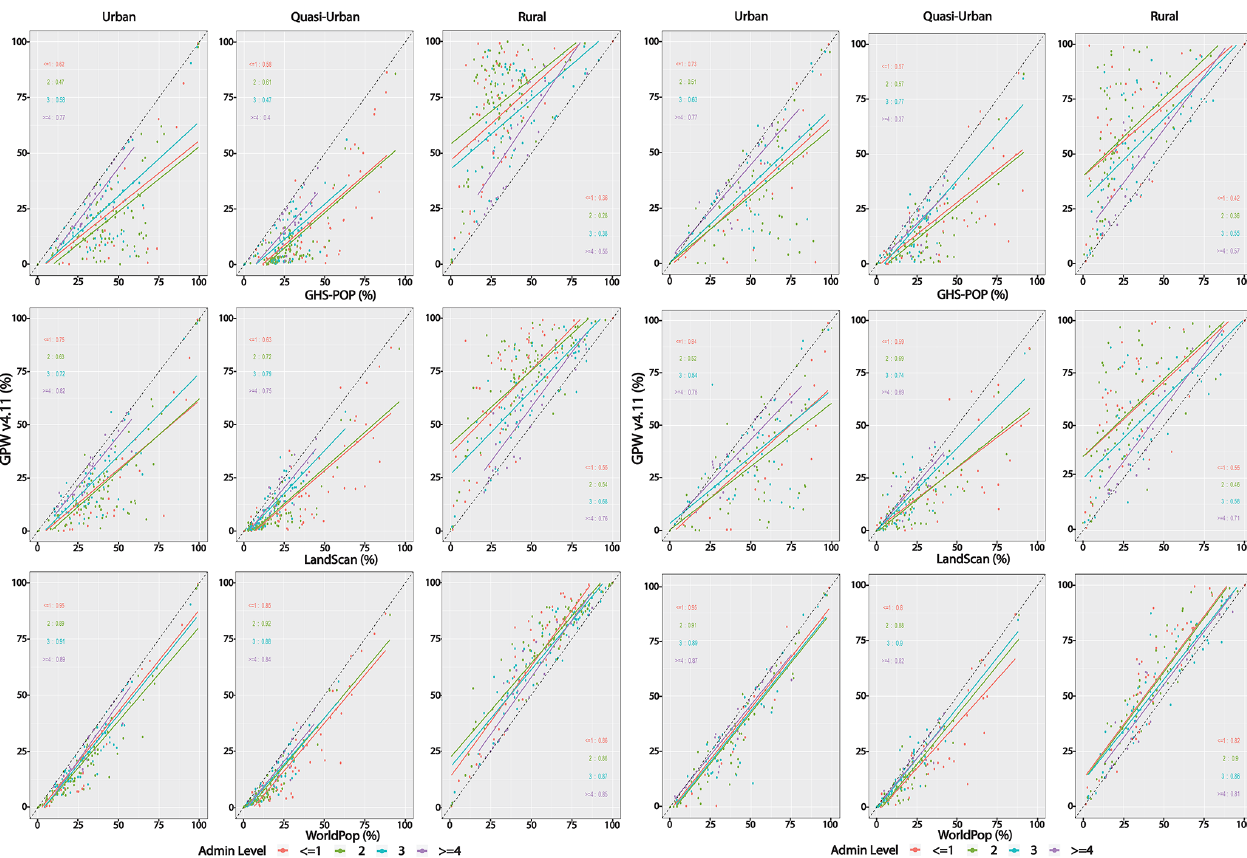
Figure B6. Comparison of population data sources by level of input unit in GPW, by urban–rural classes and urban-proxy data sets (GHS- SMOD). The left panel shows all land areas; the right panel shows area only in the ≤ 10m